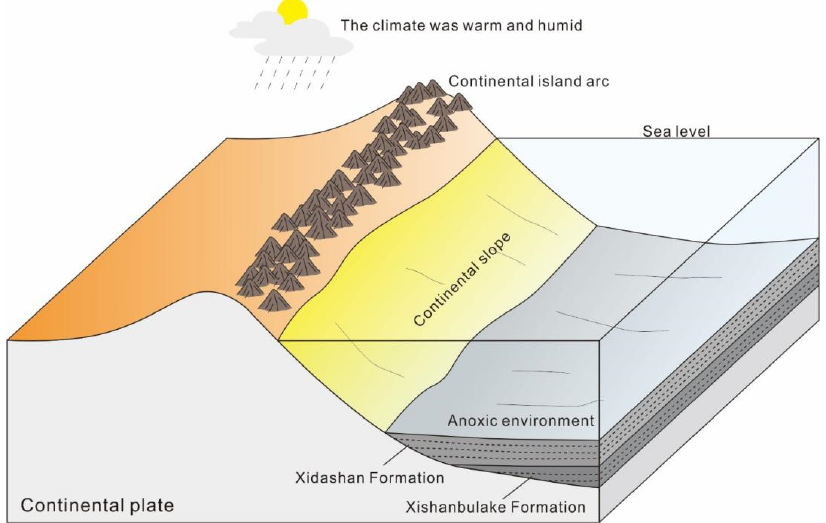
Figure 8. Tectonic development pattern of the Lower Cambrian on the Kongquehe slope, Tarim Basin.